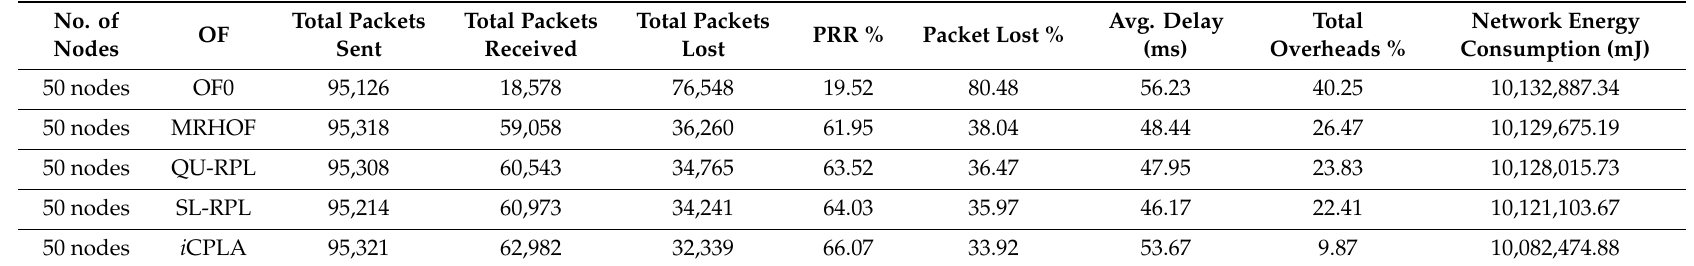
Table 2. Analysis of tree topology with varying heterogeneous tra ffi c load.